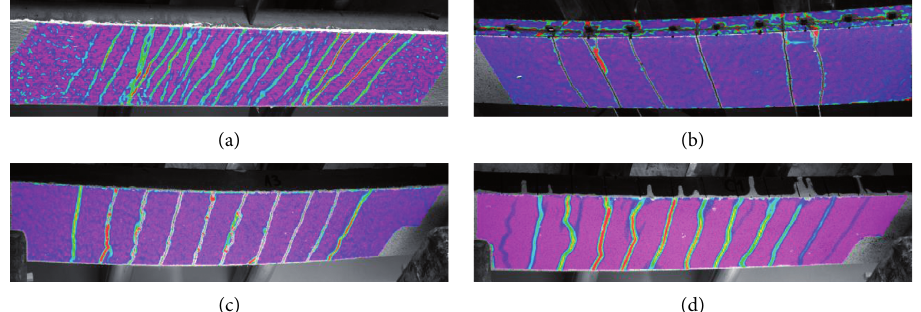
Figure 4: Crack pattern of the specimens at 5.0kN load level. (a) UHPFRC, (b) UHPC+carbon textile, (c) UHPFRC+glass textile, and (d) UHPFRC+carbon textile.